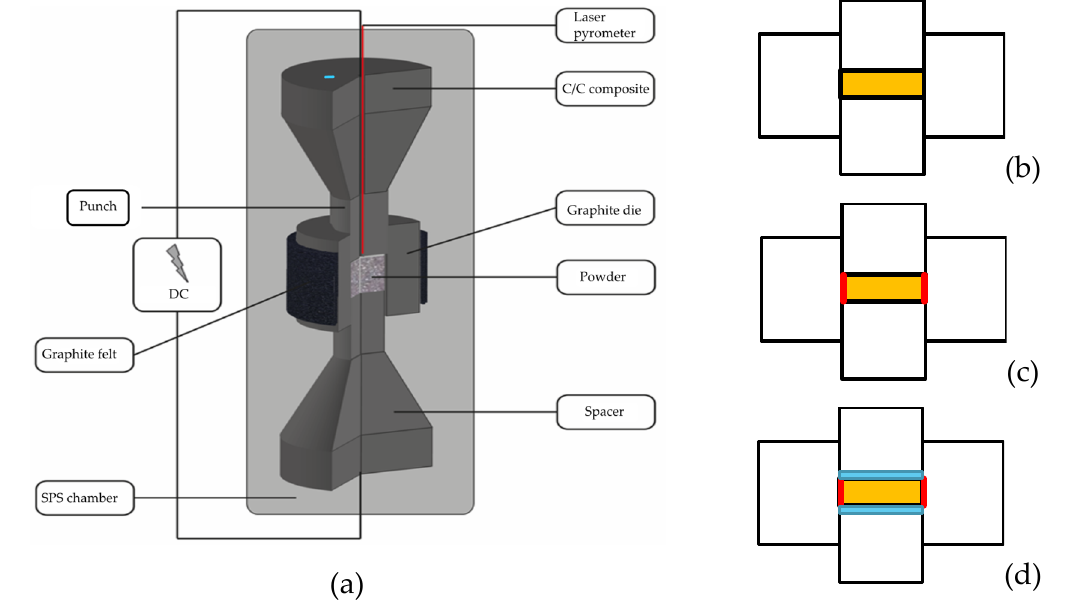
Figure 3. ( a ) General view of spark plasma sintering (SPS) assembly; (b), (c) and (d) represent different sample configurations: ( b ) classical assembly using graphite foil all around the sample, ( c ) assembly